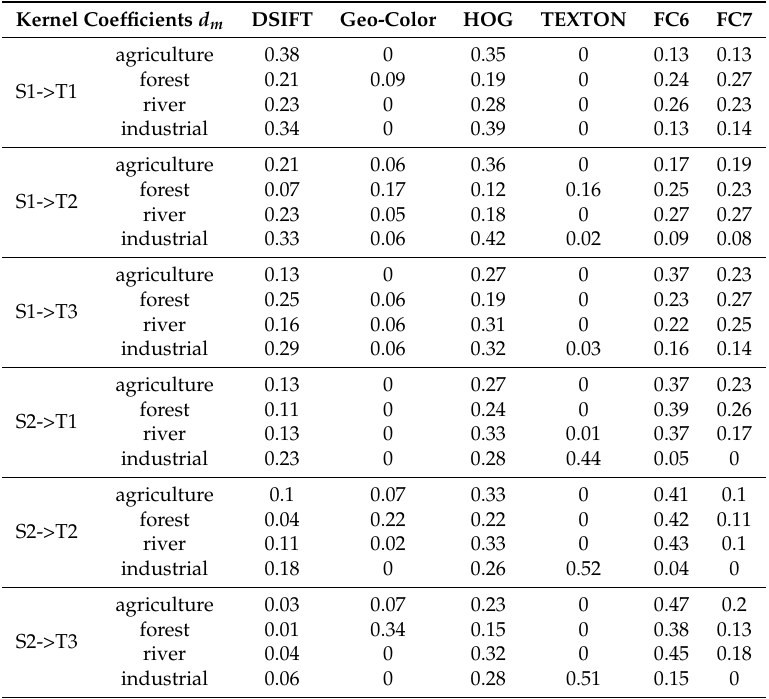
Table 2. The combination coefficients d m of the multi features with a fixed number of three target positive training samples.